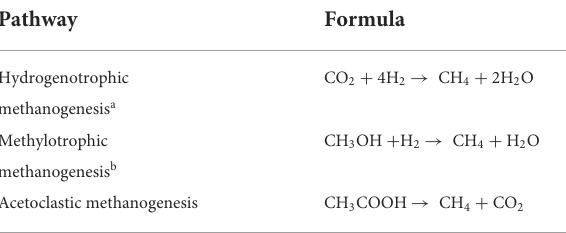
TABLE 1 The three main methanogenesis pathways in the rumen with estimates of free energies from reactions.